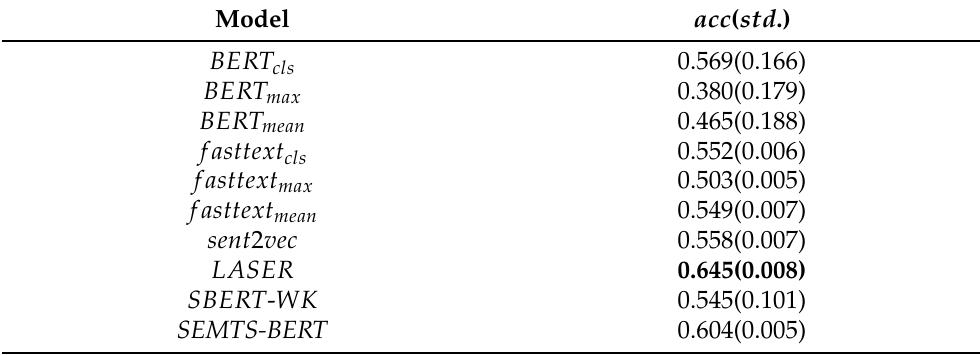
Table 4. The experimental results of the Chinese NLI. acc and std . represent classification accuracy and standard